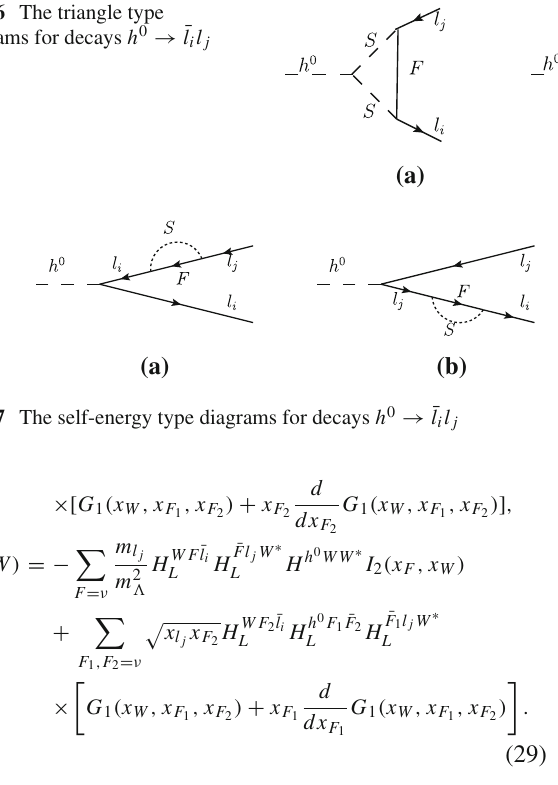
The contributions from self-energy type diagrams corre- where, the one-loop functions G i